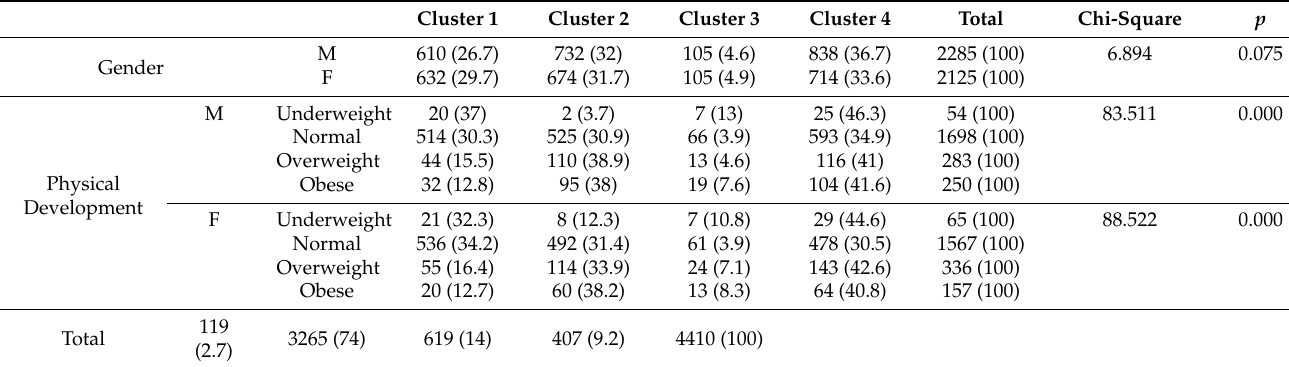
Table 2. Cross-analysis of physical fitness clusters by individual